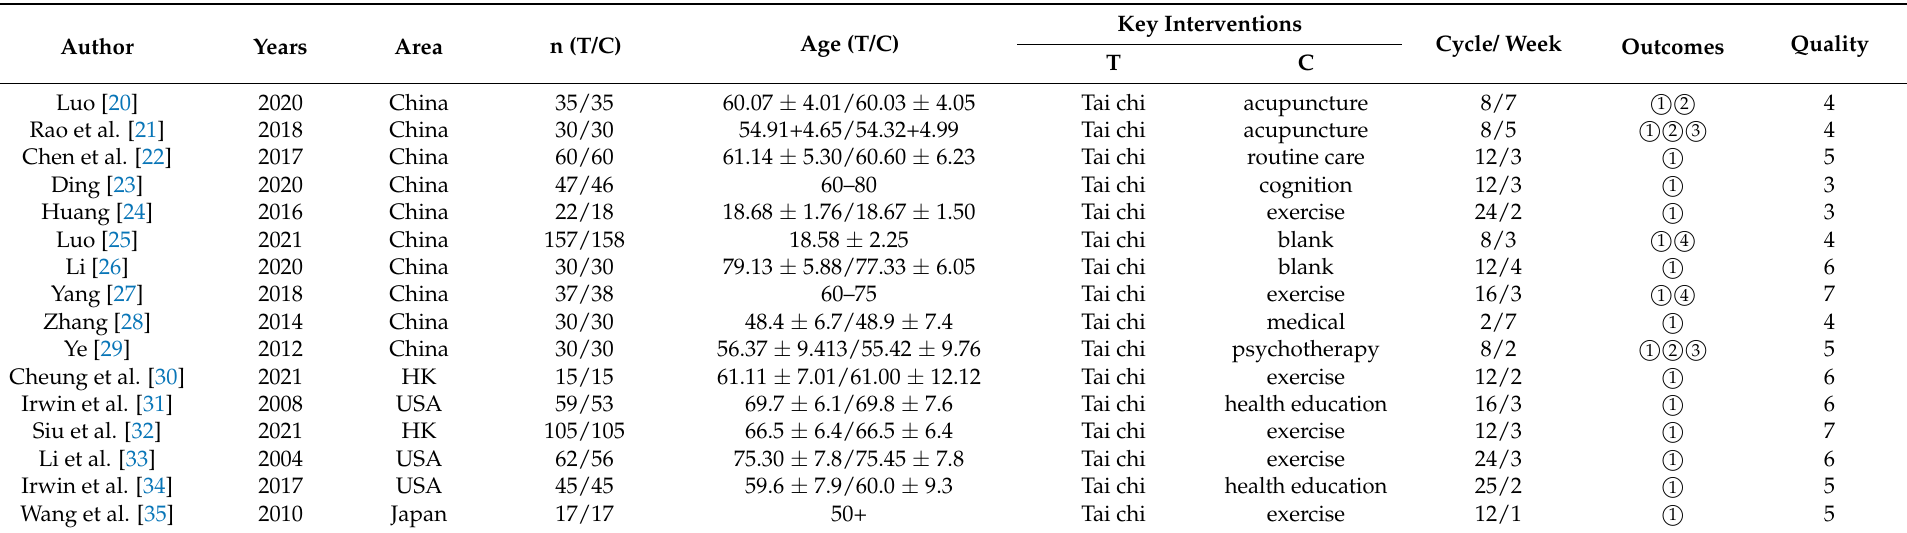
Table 1. Characteristics of the included